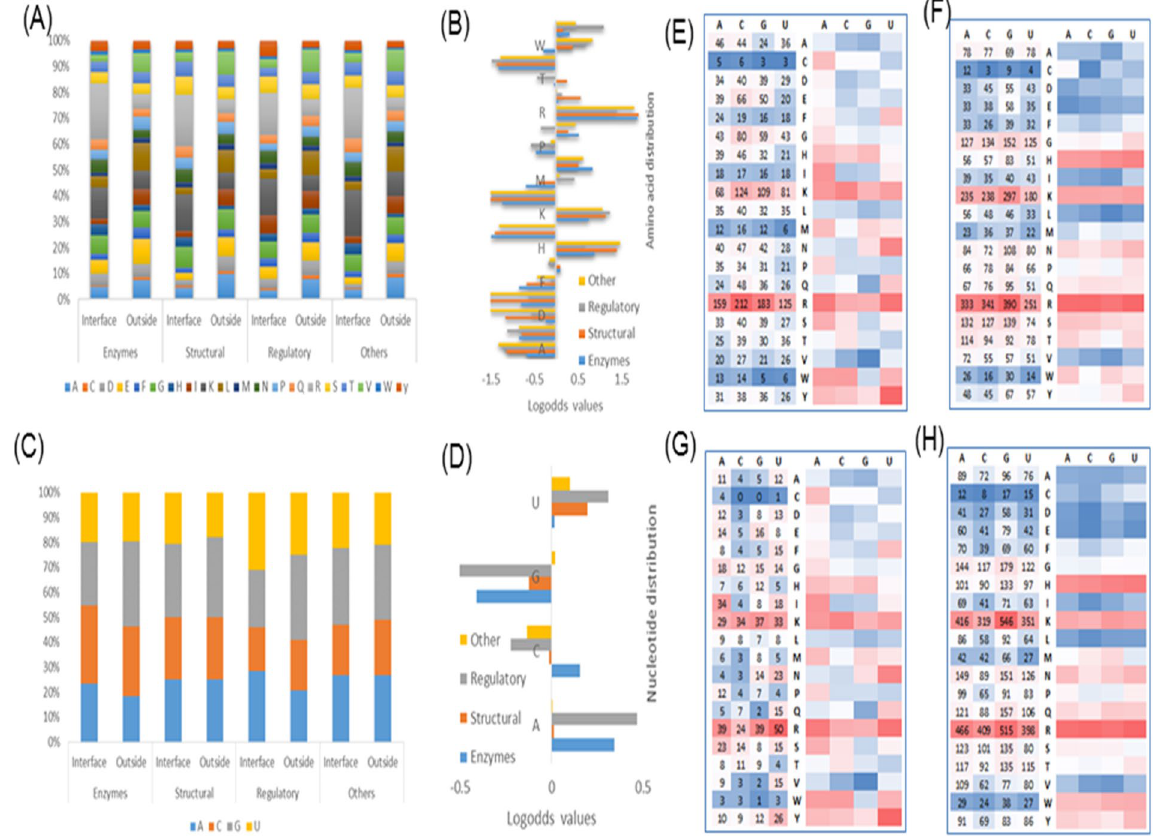
Figure 3. The occurrences of amino acid and nucleotide sequences at and outside the interface for all types of protein functional classes (enzymes, structural, regulatory, and other). The occurrences of amino acid and nucleotide at the interface and outside are shown in ( A ) and ( C ), respectively. In ( B ) and ( D ), the log-odds ratio of amino acid and nucleotide shows the over and less populated amino acid and nucleotides at and outside the interfaces. Further, the mutual interaction propensities (log-odds value) between amino acids and nucleotides are given for all four classes in ( E–H ), respectively. In each figure, the values on the left side represent the total number of contacts between residue and nucleotide and right side boxes represent their corresponding log-odds